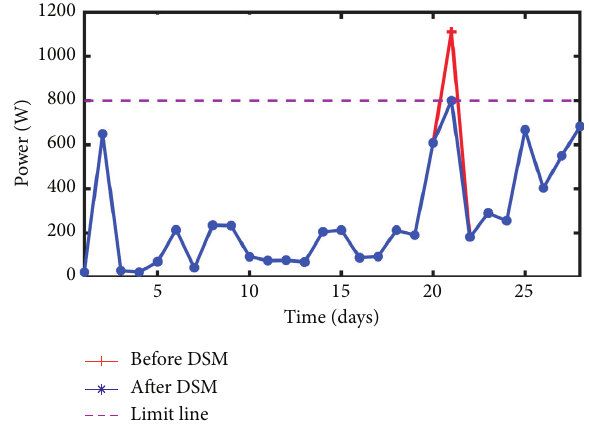
Figure 16: Load profile before and after the implementation of DSM in cluster